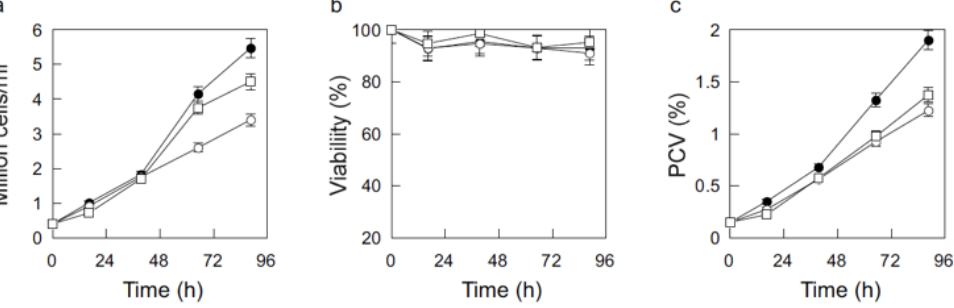
Figure 4. CHO-DG44 cell cultivation in different containers. The 100-mL cultures were inoculated in cylindrical (open circles) and square-shaped (open squares) 250-mL bottles and 250-mL HT tubes (closed circles) at a density of 0.3 × 10 6 cells/mL. The cultures were incubated at 37 °C with agitation at 110 rpm (bottles) or 160 rpm (HT tubes). At the times indicated, the viable cell density ( a ), cell viability ( b ), and biomass ( c ) were measured. The experiment was performed in duplicate. Error bars represent